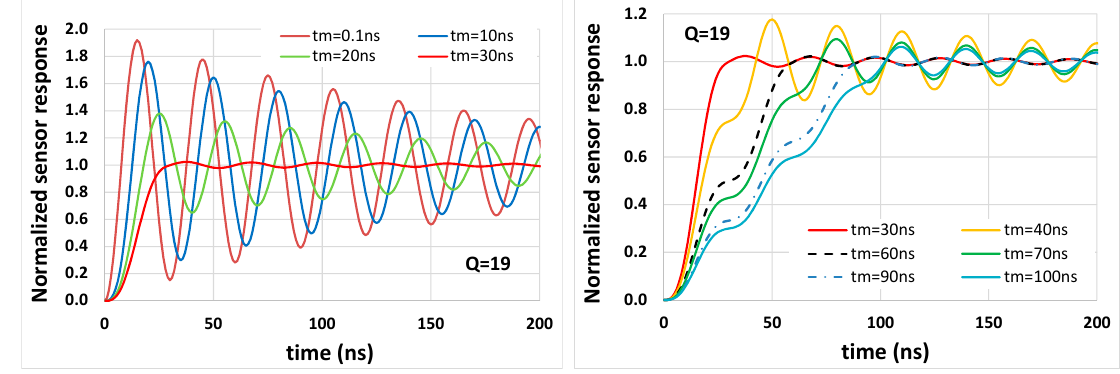
Figure 4. Dynamic sensor response for different rise times.